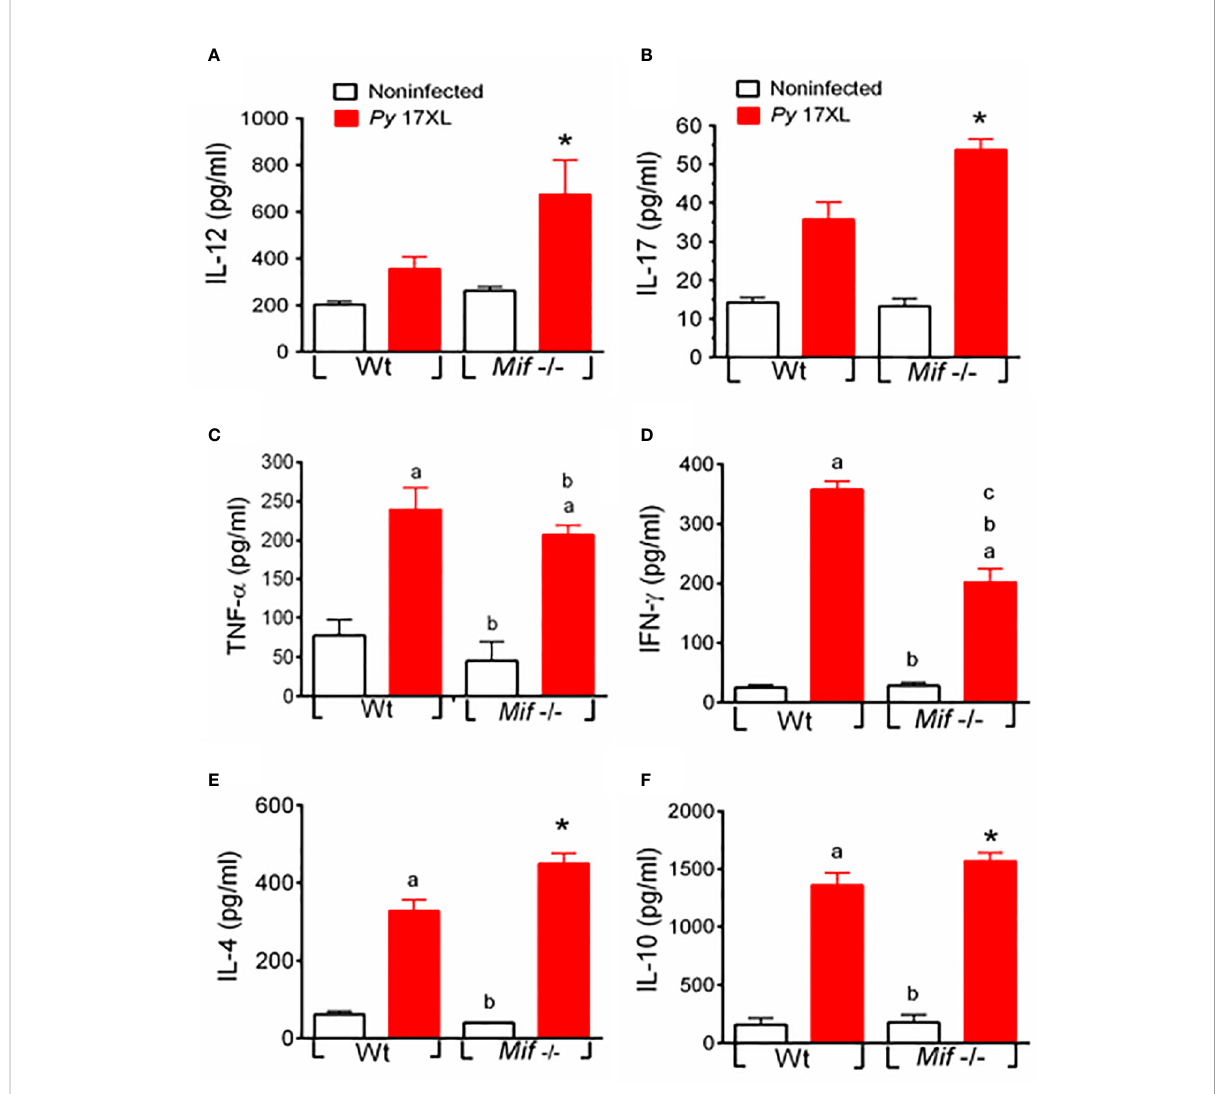
FIGURE 7 MIF de fi ciency promotes systemic IL-4, IL-10, IL-12, and IL-17 but downregulates IFN- g production during Py 17XL infection. WT and Mif -/- mice infected with Py 17XL were bled 7 days postinfection, and serum samples were obtained. Cytokines (A) IL-12, (B) IL-17, (C) TNF- a , (D) IFN- g , ( E) IL-4 and (F) IL-10 were measured in sera. Data are expressed as the mean ± SEM and are representative of 3 independent experiments with 3 to 5 mice per group. Values of p < 0.05 were considered statistically signi fi cant, (a) compared with the noninfected WT group, (b) compared with the Py 17XL-infected WT group, (c) compared with the noninfected Mif -/- group, and (*) compared with all experimental